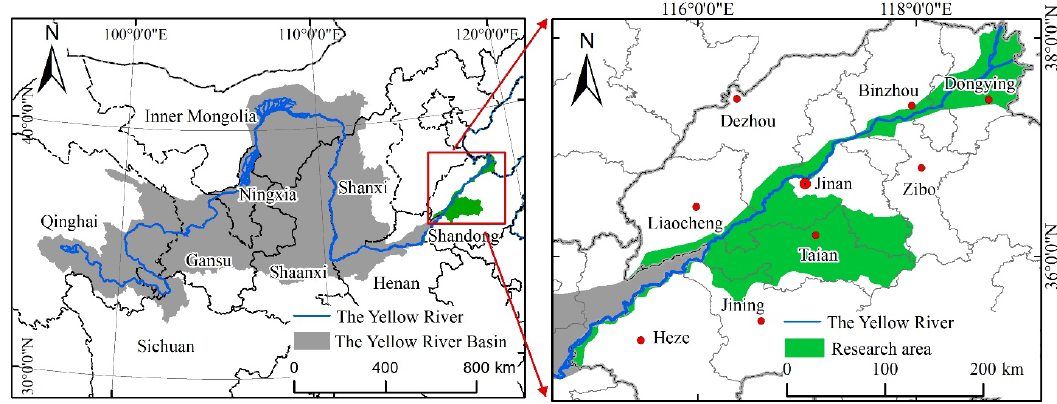
Figure 1. Geographical location and topography of the study area.